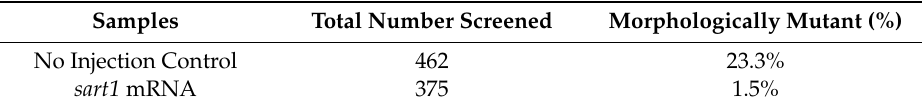
Table 3. sart1 mRNA rescues mutant